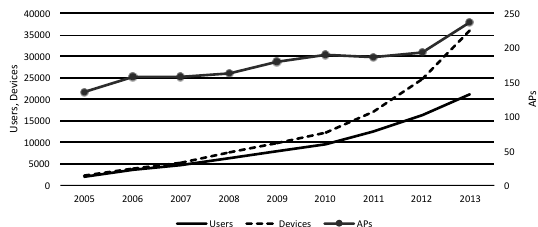
Figure 2: Evolution of devices, users and access points